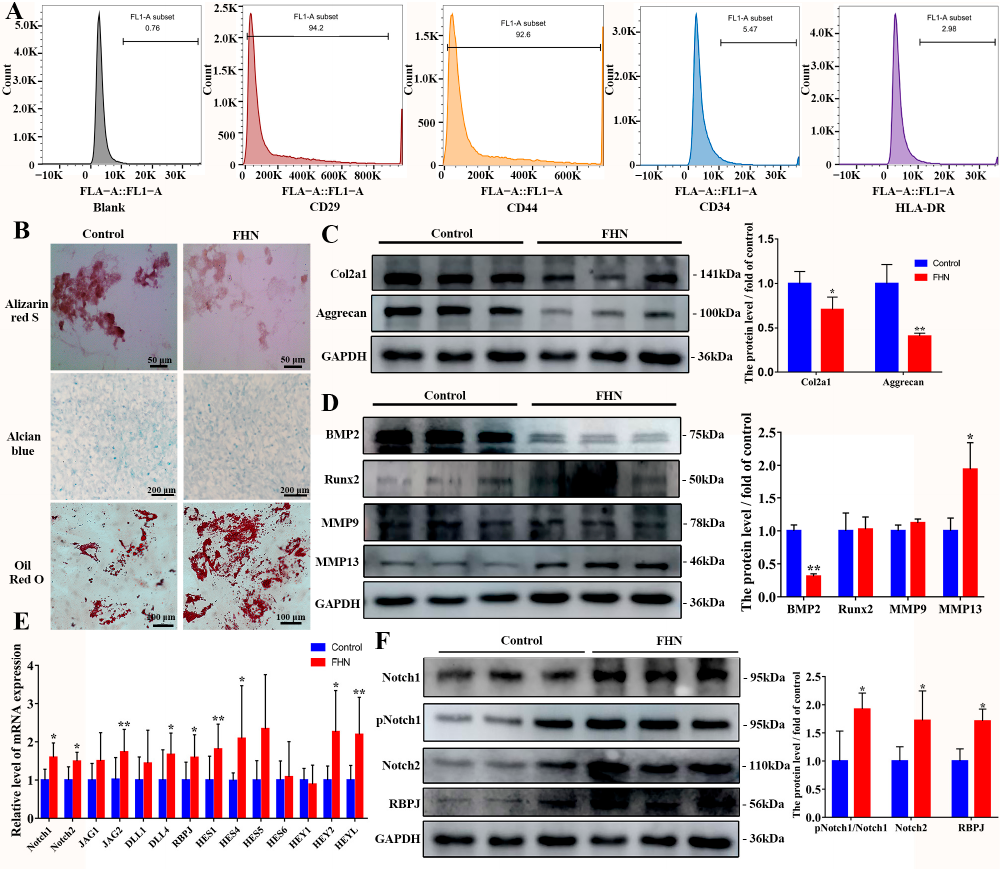
Figure 1. Attenuated osteogenic and chondrogenic differentiation capacity of BMSCs in femur tissues in FHN-affected broiler. ( A ) Identification of BMSCs surface markers by flow cytometry. Positive rate: blank: 0.76%, CD29 + : 94.2%, CD44 + : 92.6%; CD34 + : 5.47%, HLA-DR + : 2.98%. ( B ) Osteogenic, chondrogenic and adipogenesis di ff erentiation of BMSCs isolated from normal and FHN-a ff ected broilers in 21 days. The level of bone metabolism and cartilage metabolism-related proteins ( C , D ), Notch-related genes ( E ) and proteins ( F ) in femoral head tissues of normal and FHN-a ff ected broilers in 21 days. Scale bar=50 μ m, 100 μ m, 200 μm . Compared to the control group, * p < 0.05 were considered statistically signi fi cant and ** p < 0.01 means extremely signi fi cant.